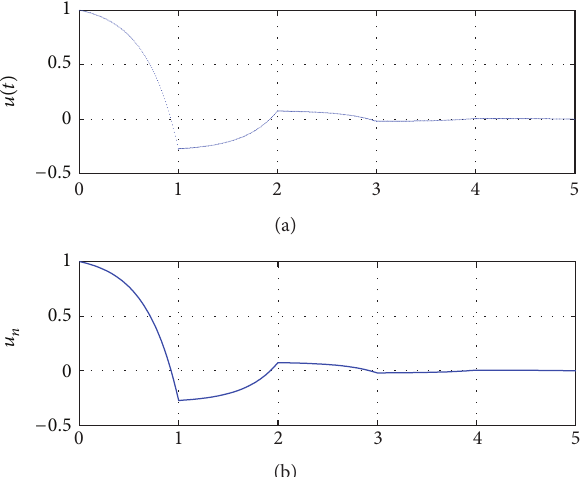
Figure 2: The stability region of (37): (a) the analytical stability region, (b) the numerical stability region with 𝑛 = 3 and 𝑚 = 20 .